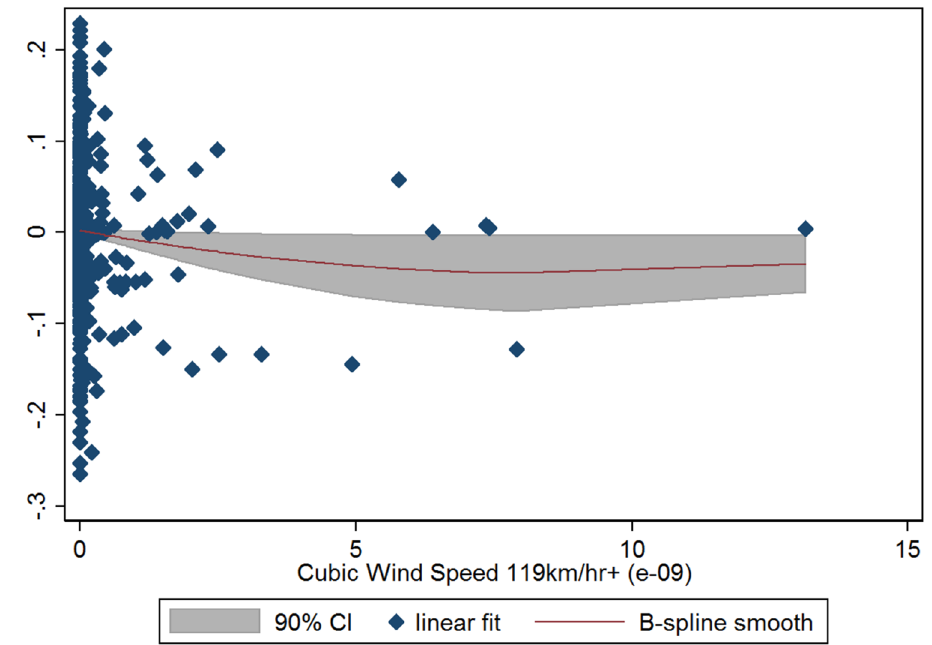
Fig. 1 Nonparametric estimated relationship between hurricanes and